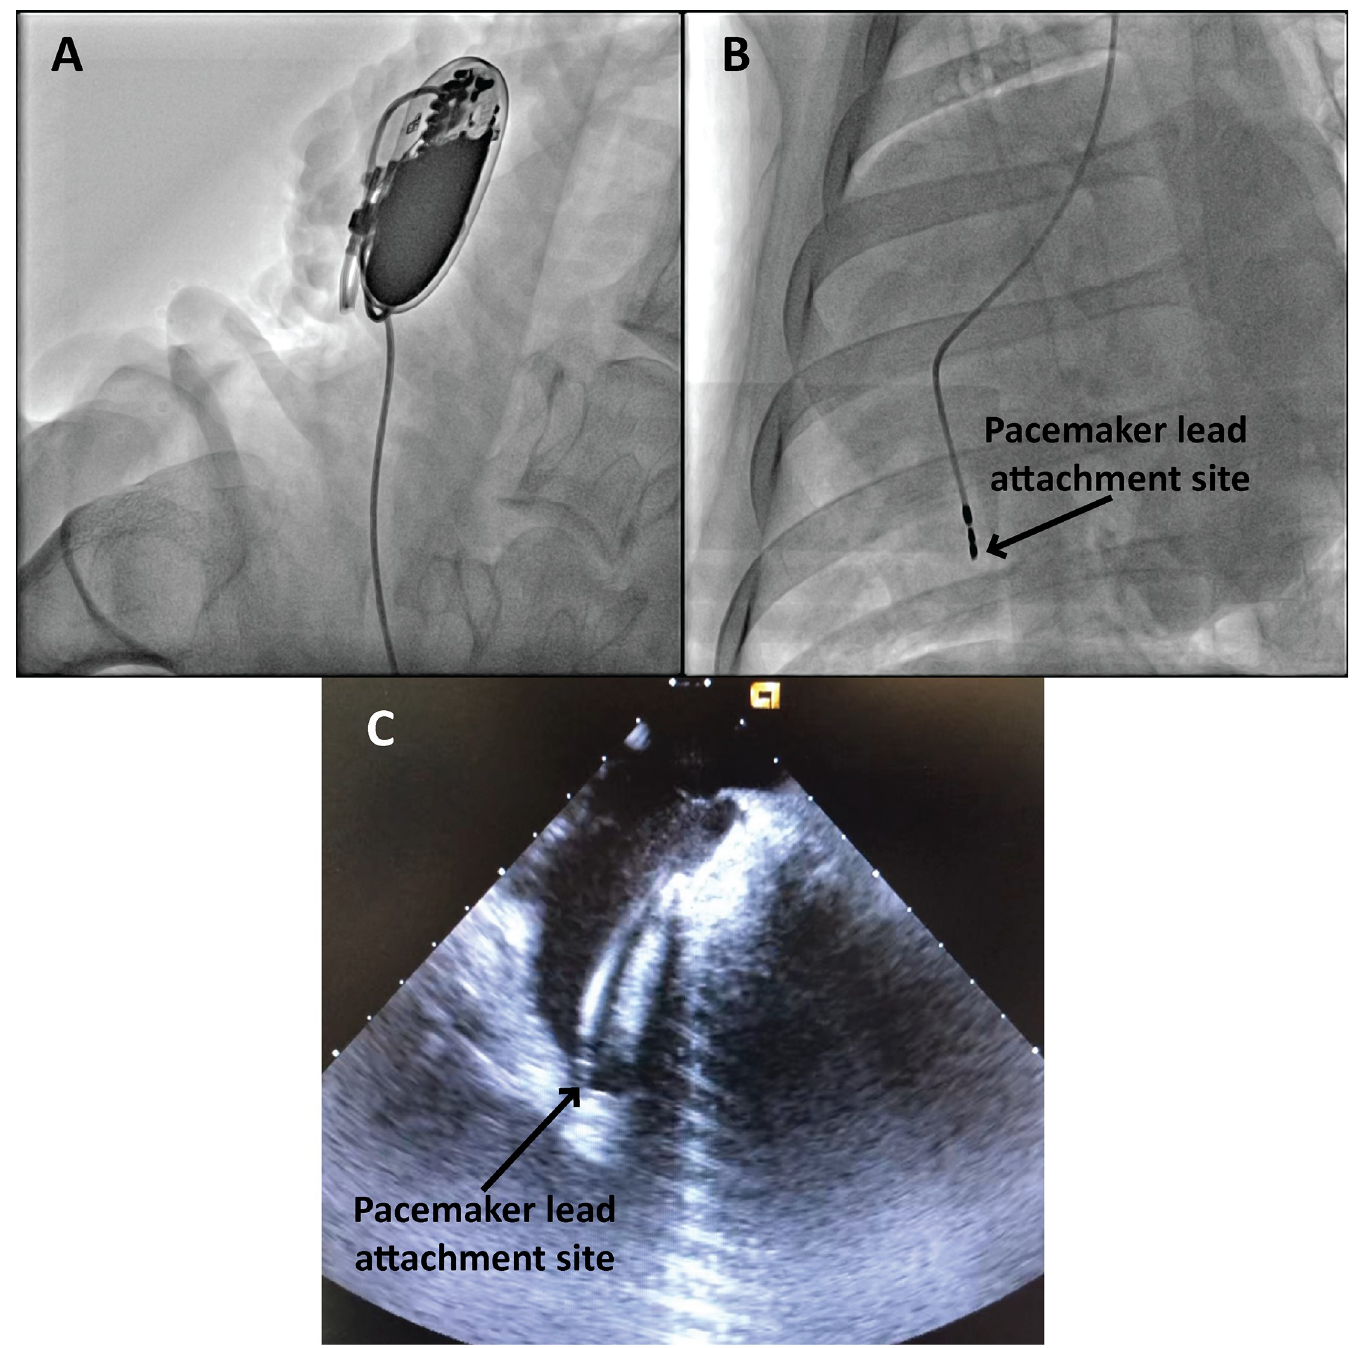
Fig 2. Representative fluoroscopy and ICE confirm anatomical location of the ventricular leads in the RV apex. (A) Fluoroscopic image demonstrating the anatomical location of the pacemaker device in the subcutaneous pocket. (B) Fluoroscopic image showing ventricular lead in the RV apex. (C) ICE image confirming position of the same ventricular lead in the RV